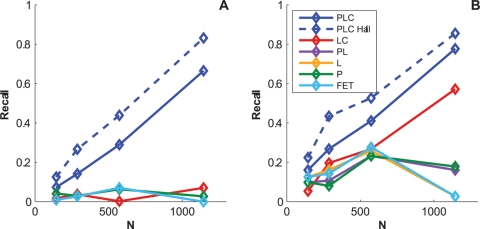
Power to detect both HLA-codon and codon-codon associations (A) or just HLA-codon associations (B) in the mixed-clade cohort at 80% precision.The “PLC Half” curve plots the power of  on synthetic data generated using only associations that were identified from a cohort one half the size of the full cohort. The curves show how power is affected by the strengths of the planted associations.